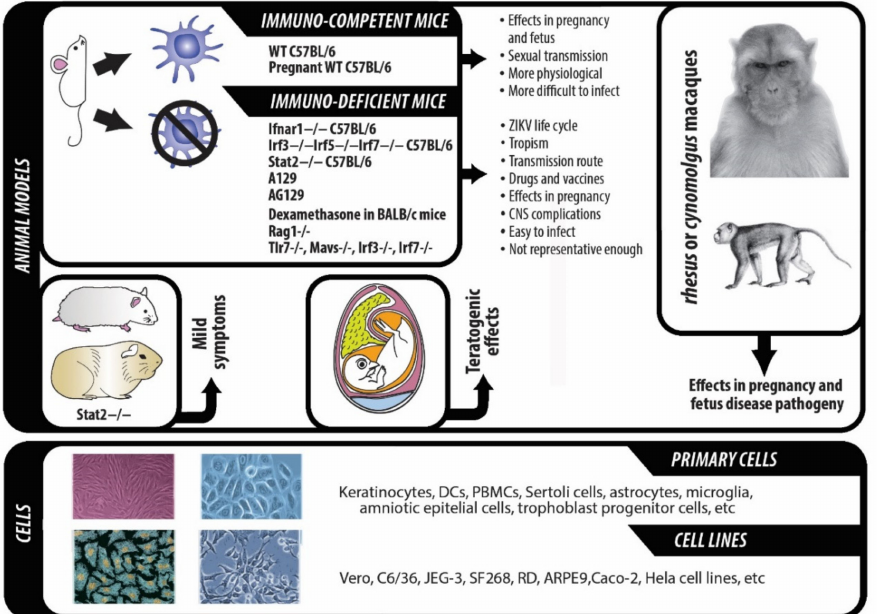
Figure 2. Cellular and animal models used to date for the study of ZIKV features, pathogenic mechanism, transmission routes and